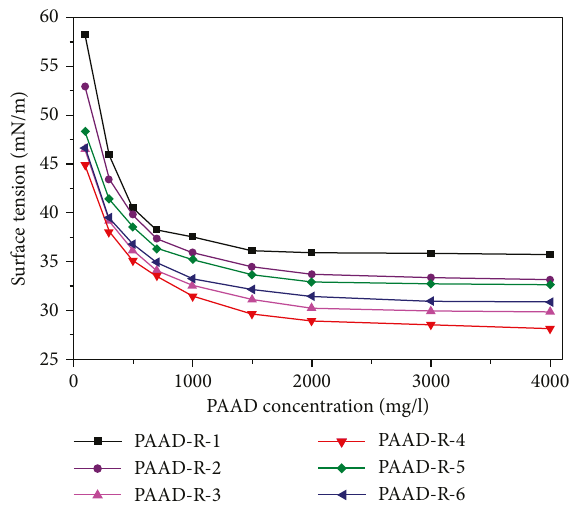
Figure 5: Variation of the apparent viscosity with concentration of PAAD at the shear rate of 0.6 s − 1 in water with the NaCl concentration of 1000 mg/l at 25 ° C.